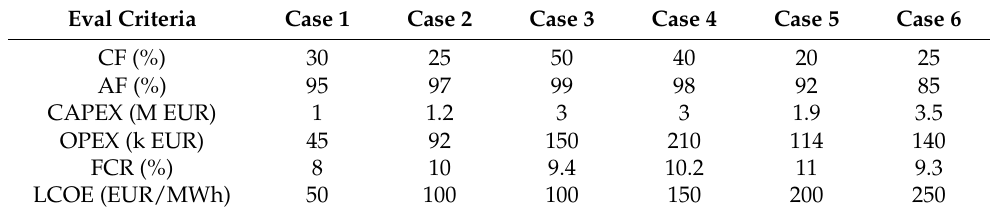
Table 8. Assessment of wave energy